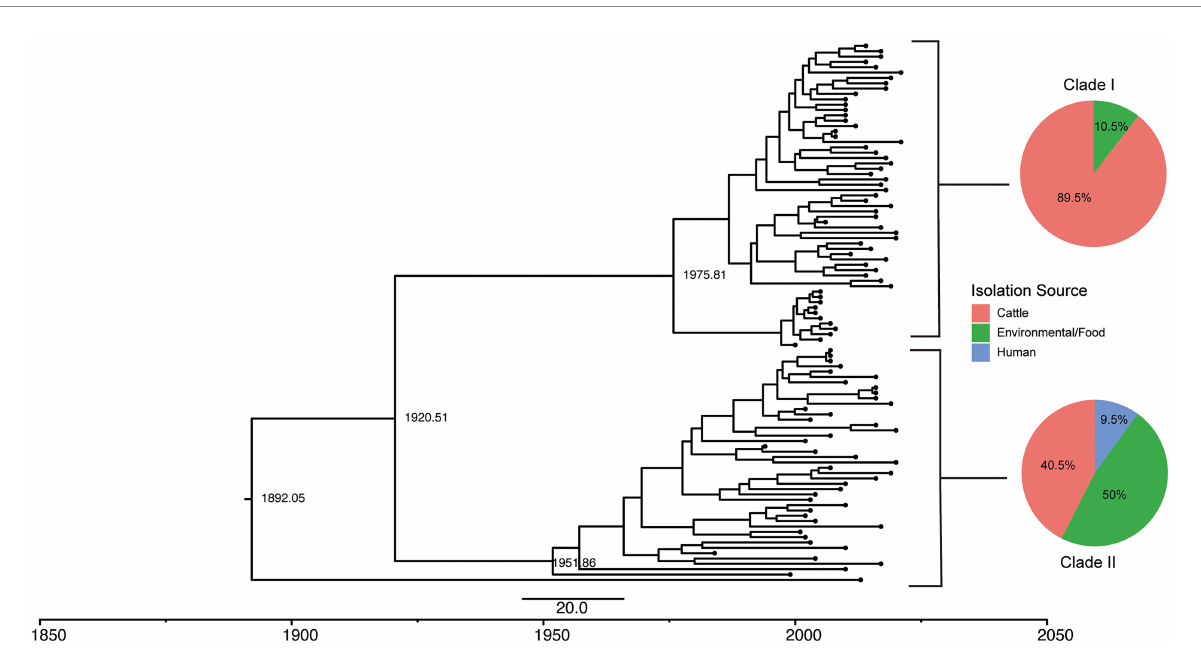
FIGURE 5 Tip-dated phylogeny of 100 S. Cerro ST367 isolates shows two clades, one of which is cattle associated. A rooted tree was constructed in BEAST with high quality core SNPs using the model 23 substitution model, lognormal relaxed molecular clock, and coalescent constant size population model in five independent runs of 400 million MCMC simulations. Estimated dates of divergence are displayed for the major clades. Pie charts of isolation source of all isolates in SNP clusters belonging to clades I and II are displayed next to their representative